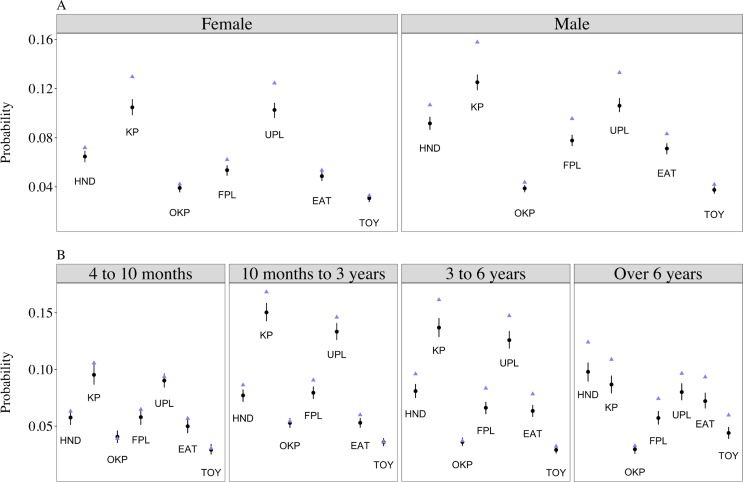
Predicted probabilities of aggression towards people in different contexts by sex (panel A) and age groups (panel B).Black points and vertical lines show mean and 95% highest density intervals of model parameter estimates; blue triangles show raw sample data. Model estimates were obtained by marginalising over the random effects (see the Supporting Information). Abbreviations used in the figure: HND (Handling); KP (In kennel towards people); OKP (Out of kennel towards people); FPL (Interactions with familiar people); UPL (Interactions with unfamiliar people); EAT (Eating food); TOY (Interactions with toys).